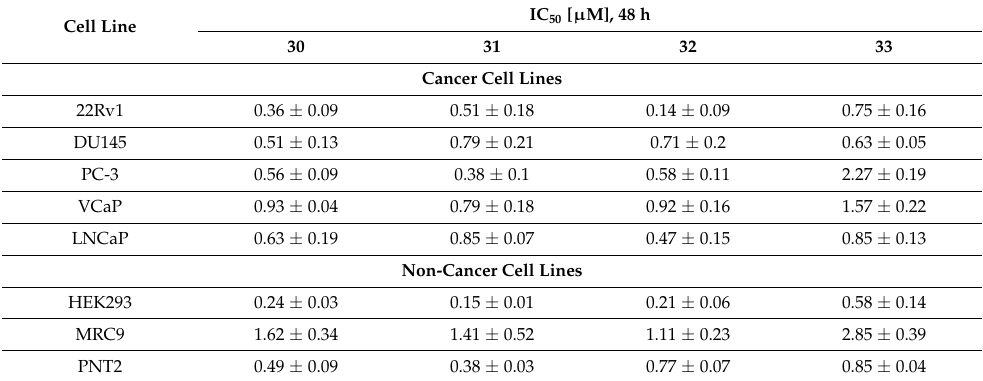
Table 2. IC 50 values of 30 , 31 , 32 , and 33 in different cell lines. The cells were treated with the investigated compounds for 48 h. IC 50 values were evaluated using the MTT